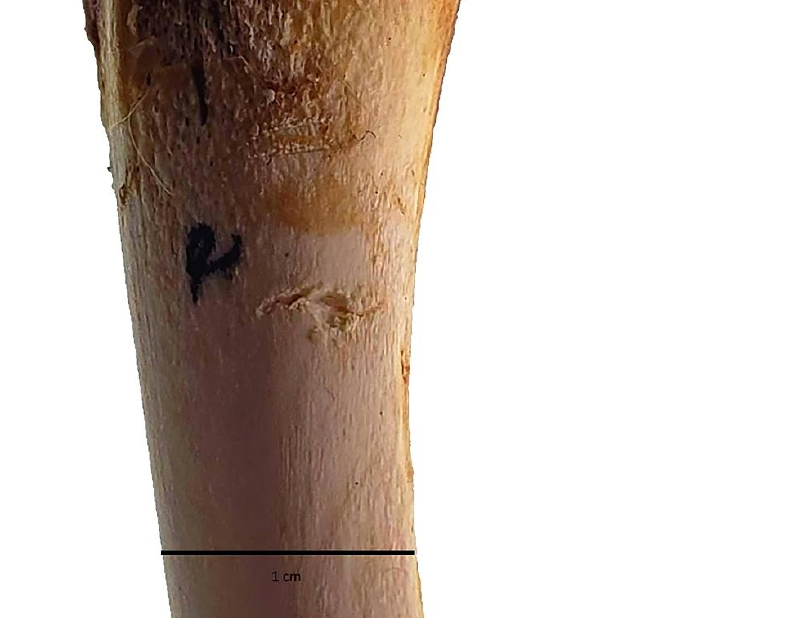
Table 5. Frequency distribution of experimental ground stone axe chop marks by Fragmentation Class.